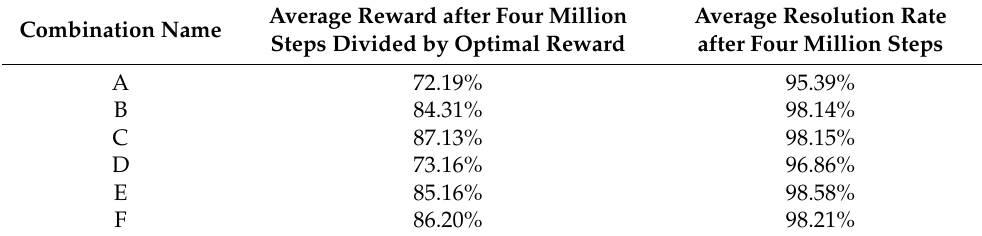
Table 5. Training data of six parameter combinations.